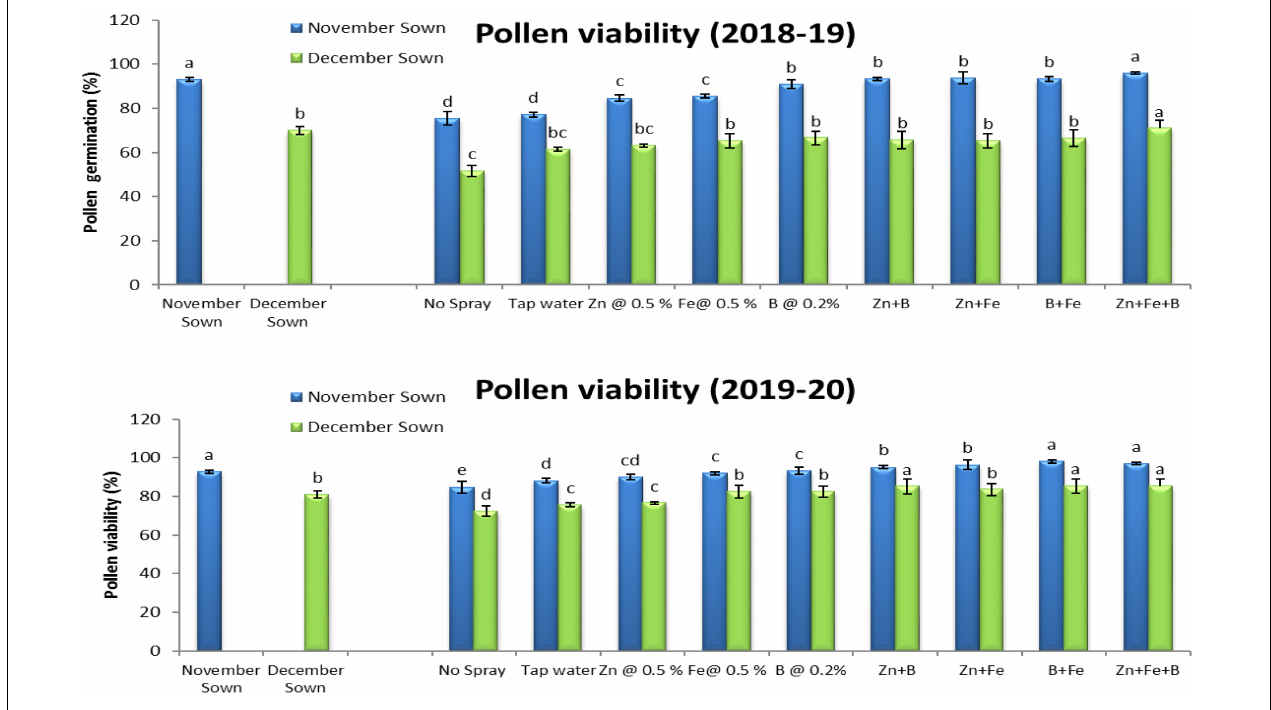
FIGURE 3 | Pollen viability (%) for different sowing dates and foliar spray treatments in the 2018–19 and 2019–20 lentil cropping seasons. Values are means, and bars represent ± SEM ( n = 3). Different letters indicate significant differences between